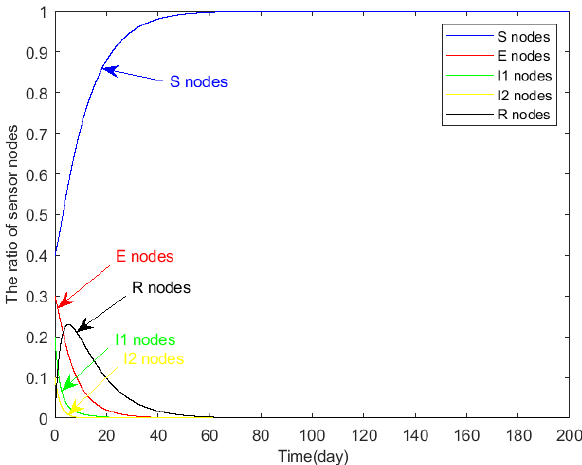
Figure 7. Evolution of sensor nodes when γ 1 = γ 2 = 1.